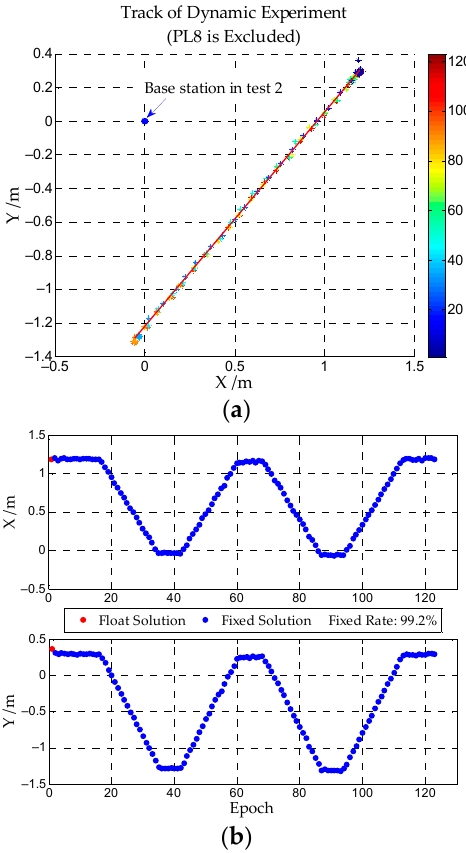
Figure 16. ( a ) The trajectory of Experiment2 after FaultExclusion, ( b ) Results in the X, Y Direction of Experiment 2 after FaultExclusion.